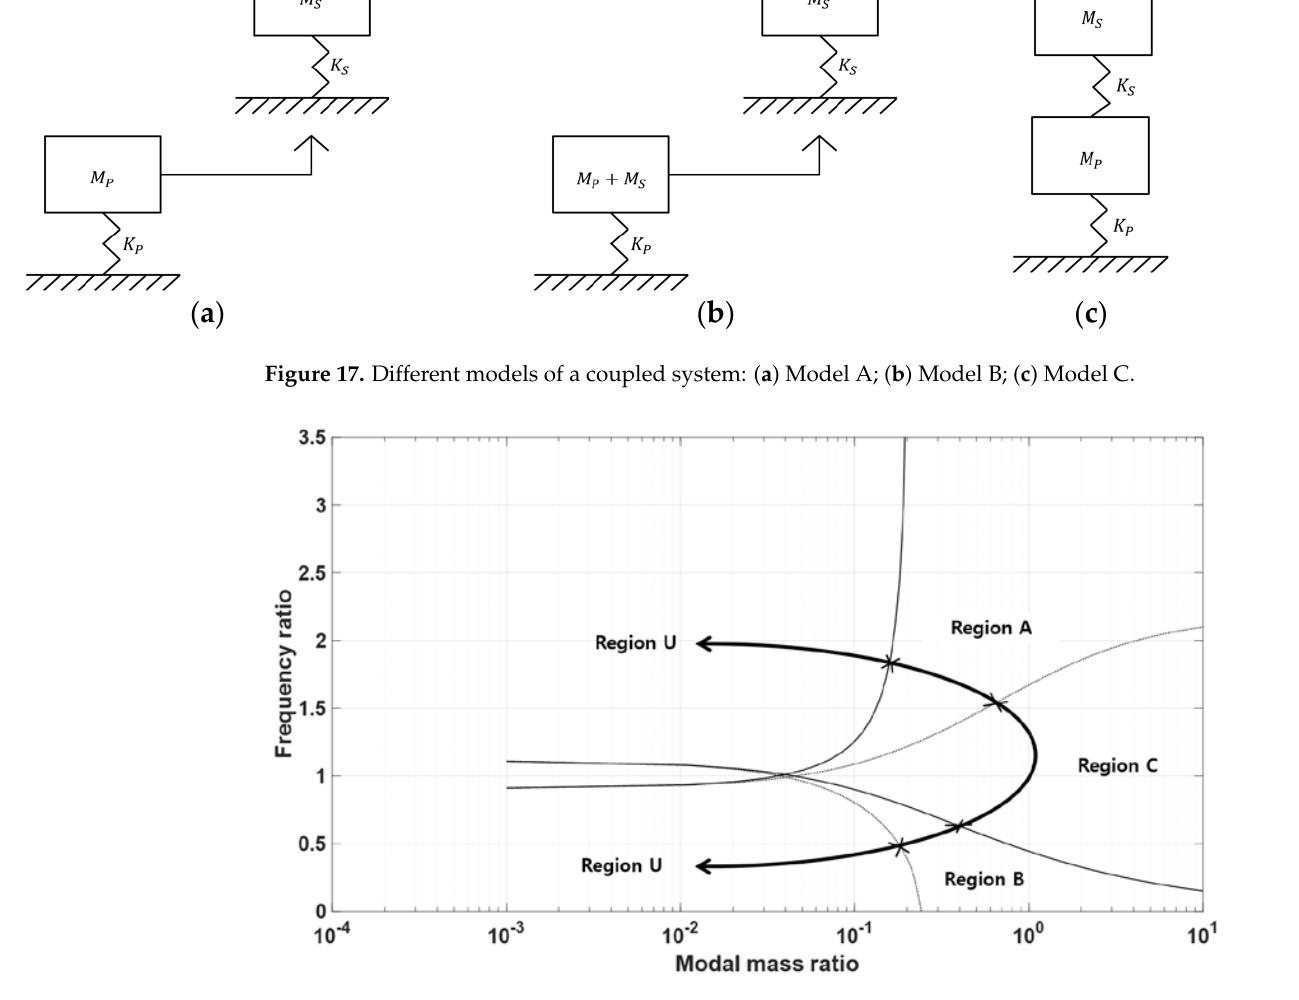
Figure 18. Criteria for modeling a coupled system.